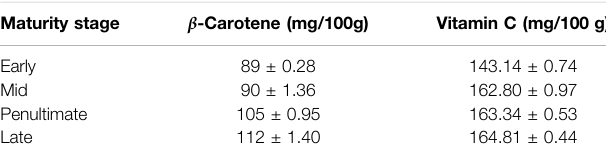
TABLE 5 | β -carotene and vitamin C contents in the M. oleifera leaf at different maturity stages. Maturity stage